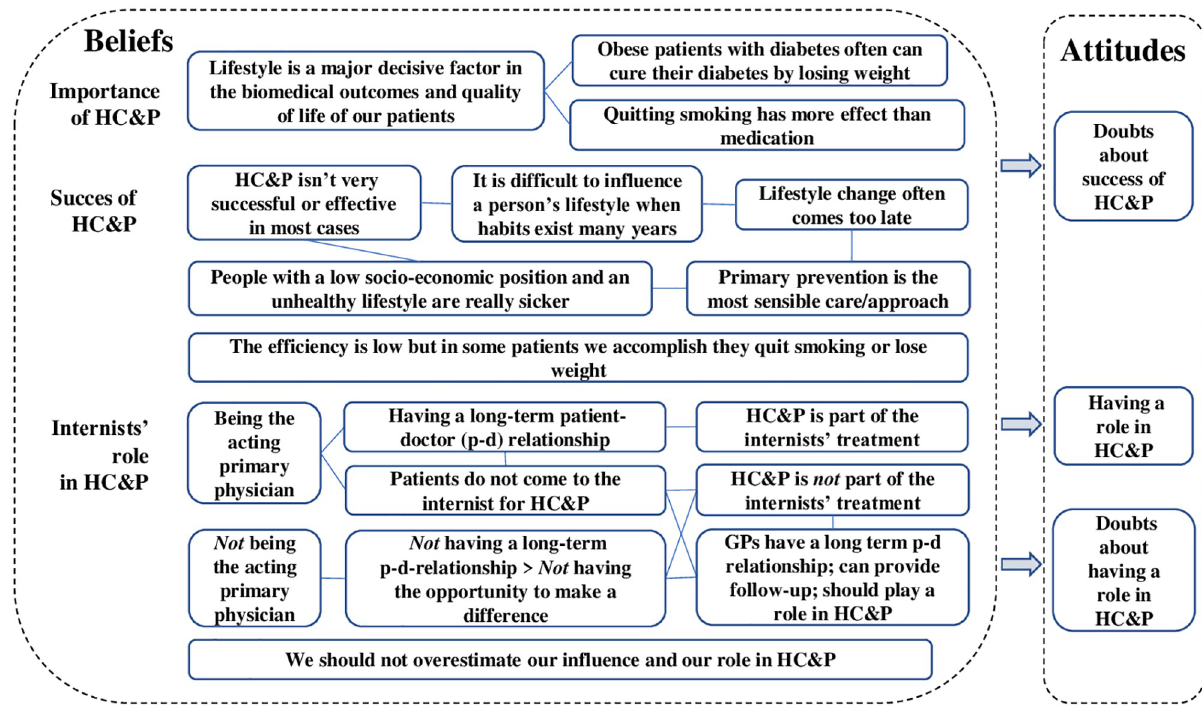
Fig 2. Schematical overview of beliefs and attitudes about the importance and success of HC&P, and the internists’ role in HC&P.